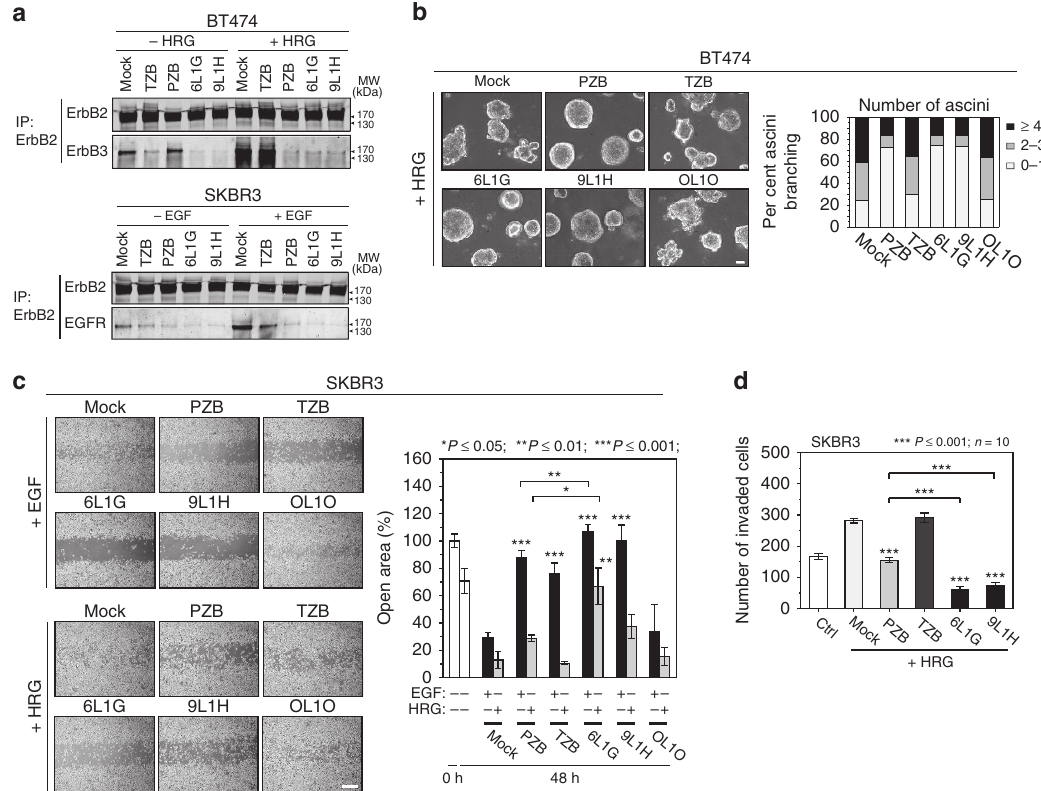
Figure 5 | Pan-ErbB2 inhibition abolishes heterodimerization of ErbB2 irrespective of the presence of ligand. ( a , b ) Inhibition of ligand-dependent and ligand-independent ErbB2 heterodimers. After preincubation with 100nM of the anti-ErbB2 agents, ErbB2–ErbB3 dimerization was triggered with 1nM heregulin- b 1 (HRG) in BT474 cells (top) and ErbB2–EGFR dimerization with 4nM epidermal growth factor (EGF) in SKBR3 cells (bottom). Receptors were crosslinked with reducible crosslinker DTSSP. ( a ) ErbB2 was immunoprecipitated by anti-ErbB2-C-terminal antibody, and the co-immunoprecipitated receptor was determined by immunoblot analysis. ( b ) Micrographs show HRG-induced morphogenesis (acini branching) after 12 days of co-treatment (top). Spheroid branching was quantified by three times scoring of 100 acini classified into three populations (bottom), depending on the number of buds per acinus. Scale bar, 50 m m. ( c ) Effect of the ErbB2-targeting agents on cell migration. SKBR3 cells were seeded to confluence, and scratch wounds of 500 m m were made in the monolayers. Cells were treated with the indicated agents (100nM) and co-stimulated with 4nM EGF or HRG. Left, representative micrographs were taken after 48h. Right, the cell migration was expressed as per cent open area relative to the area at time point 0h (* P value versus respective mock (EGF/HRG) or as drawn, two-sided, unpaired Welch’s t -test). Scale bar, 500 m m. ( d ) Effect of the ErbB2-targeting agents on cell invasion induced by HRG. SKBR3 cells pre-seeded on Matrigel in a Boyden-type invasion chamber were treated with the indicated agents (100nM) and co-stimulated for 72h with 1nM HRG. Data are mean ± s.e.m. (* P value versus mock ( þ HRG) or as drawn, Mann–Whitney test). NATURE COMMUNICATIONS|7:11672|DOI: